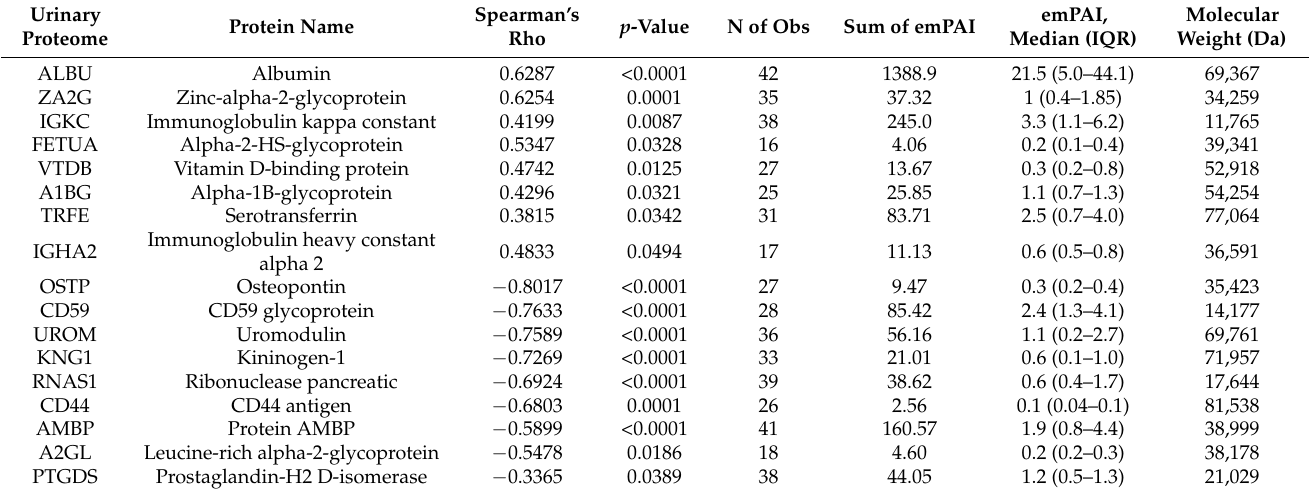
Table 2. Correlations between the level of 24 h Protein excretion and the emPAI of Urinary Proteome.